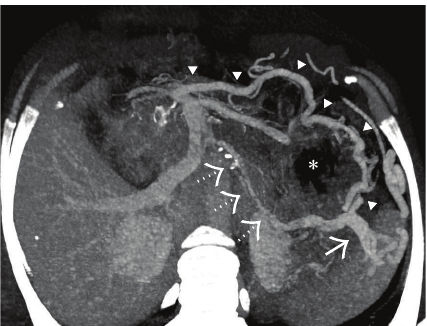
Figure 42: Axial MIP image showing a severely attenuated and partially calcified retropancreatic splenic vein (interrupted arrows) resulting in formation of a prominent gastroepiploic collateral channel (arrowheads) between the SMV and the remnant splenic vein at splenic hilum (solid arrow) along the greater curvature of stomach. Asterisk denotes the gastric lumen.